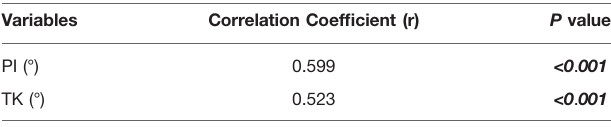
TABLE 2 | Correlation between lumbar lordosis and the variables.